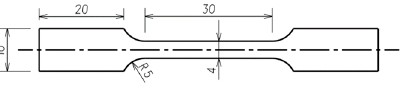
Figure 1. Schematic diagram of tensile specimen.